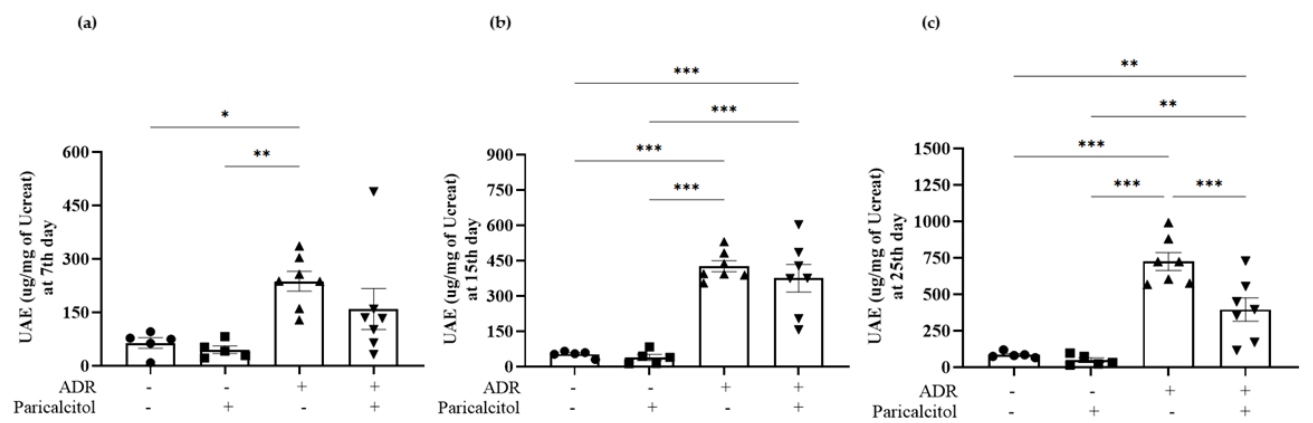
Figure 2. Urinary albumin excretion (UAE) at the 7th- day ( a ), 15th- day ( b ), and 25th- day ( c ) of the experiment. The data from the control (dots), paricalcitol (squares), ADR (up triangles), and ADR + paricalcitol (down triangles) groups at 27 days of paricalcitol treatment. n = 5–7 for each group. The data are expressed as the mean ± SEM. * p < 0.05; ** p < 0.01; *** p < 0.001.